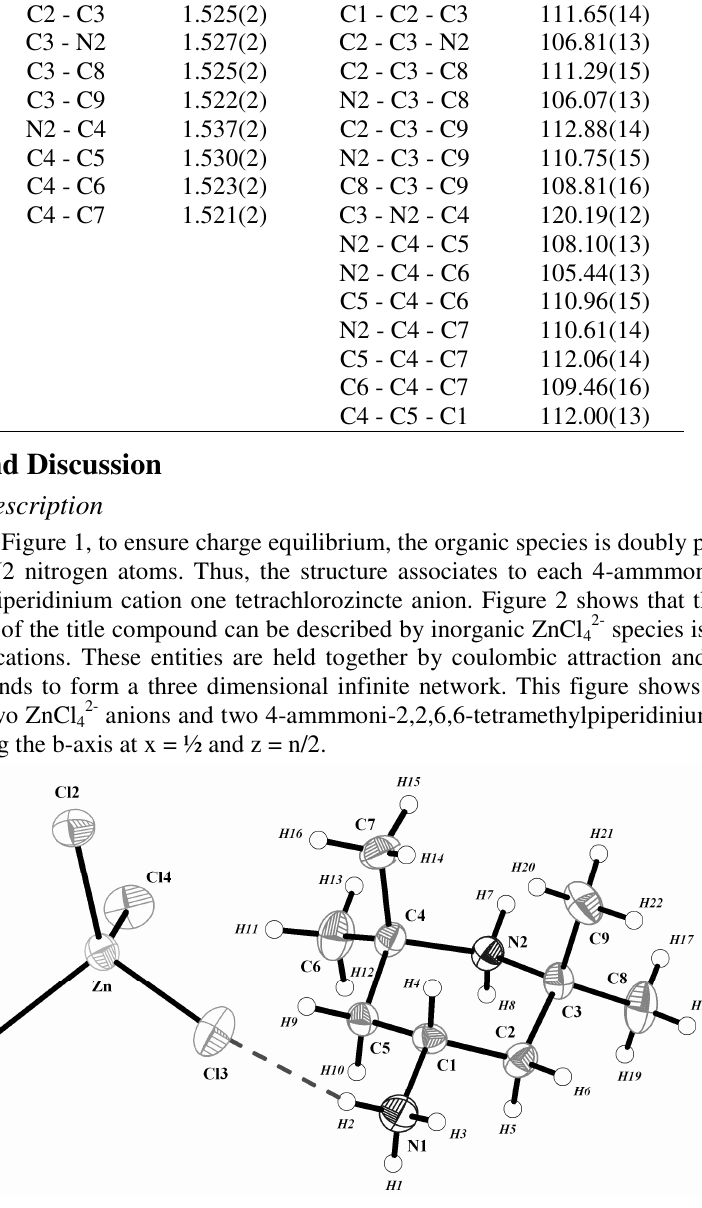
H N ]ZnCl with atom labels and 40% probability 9 22 2 4